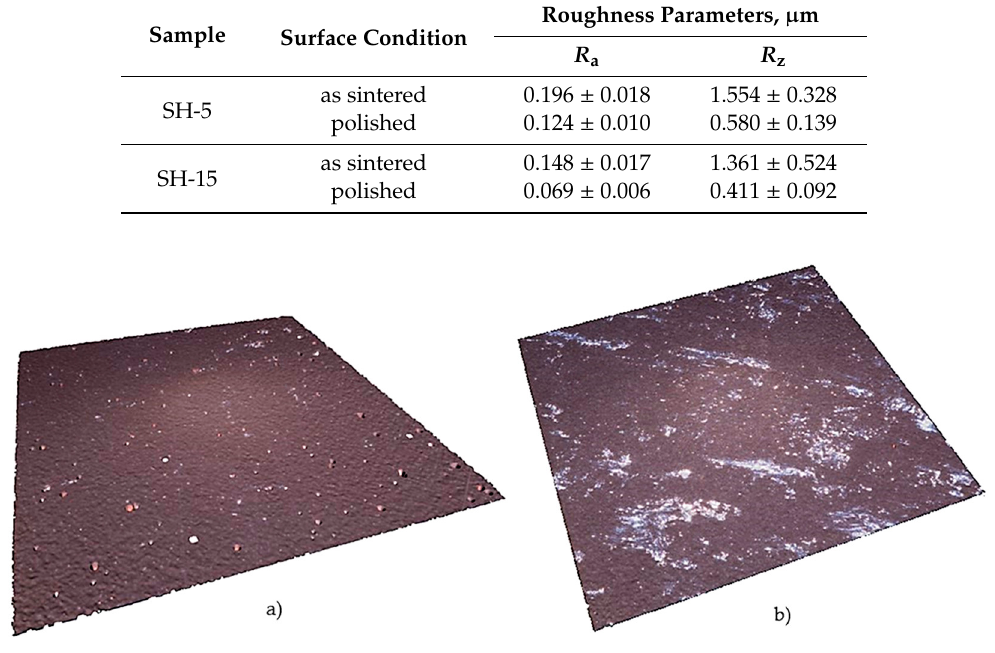
Figure 10. Surface topography of the substrates: ( a ) SH-5; ( b ) SH-15 .